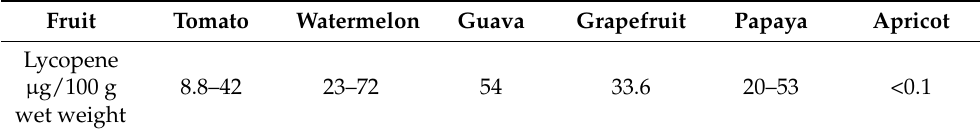
Table 1. Lycopene content of some fruits and vegetables [16].